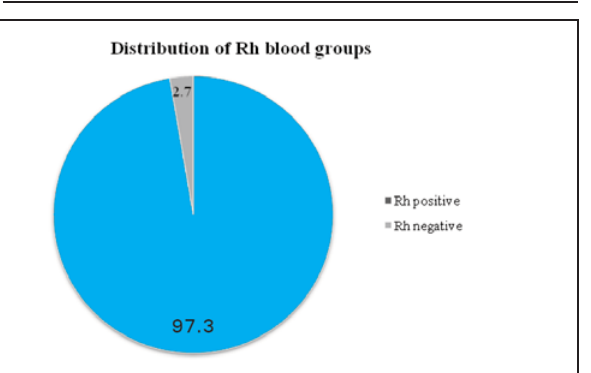
Figure 1. Bar diagram showing distribution of ABO blood groups.